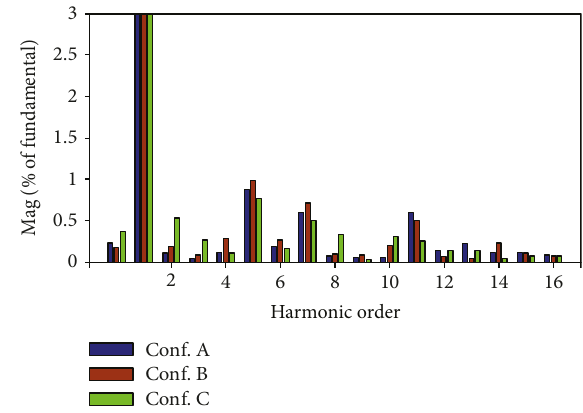
Figure 12: Harmonic spectrum of the grid current ( I